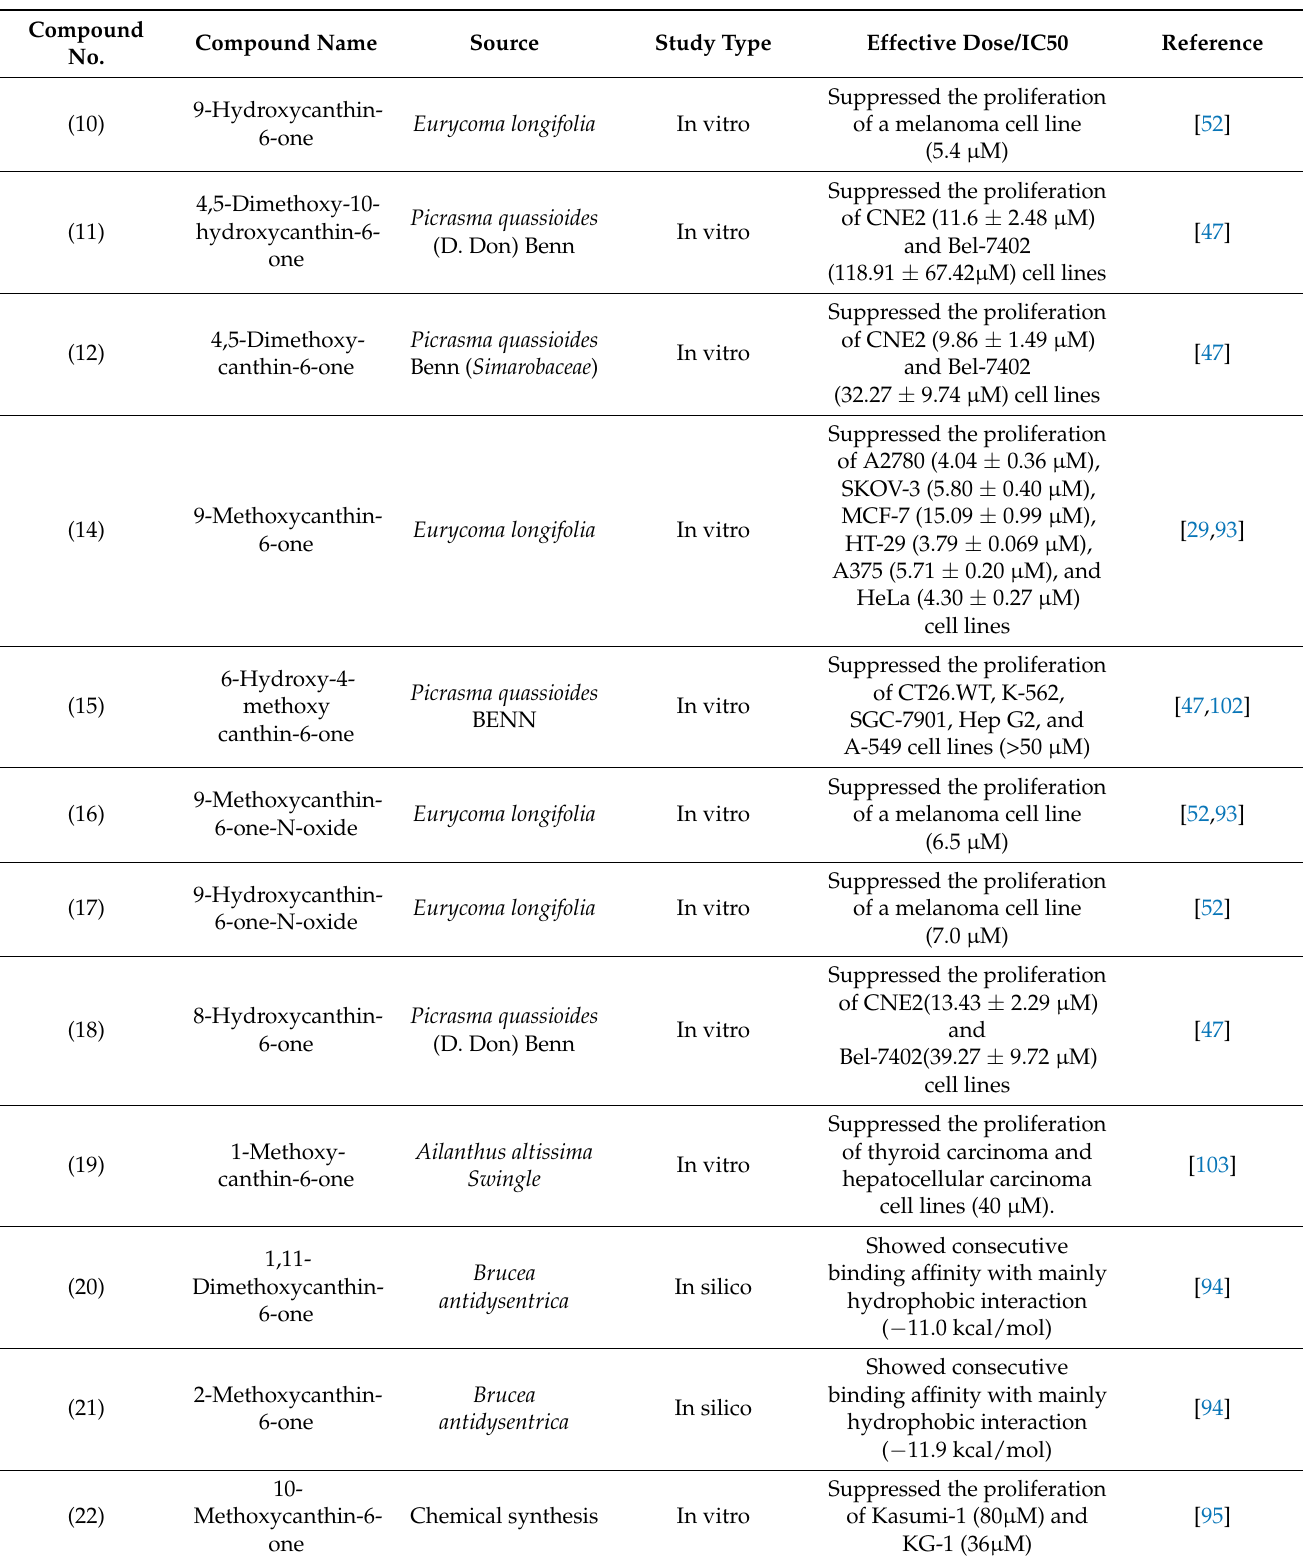
Table 2. Canthin-6-ones exert anti-tumor activity via various